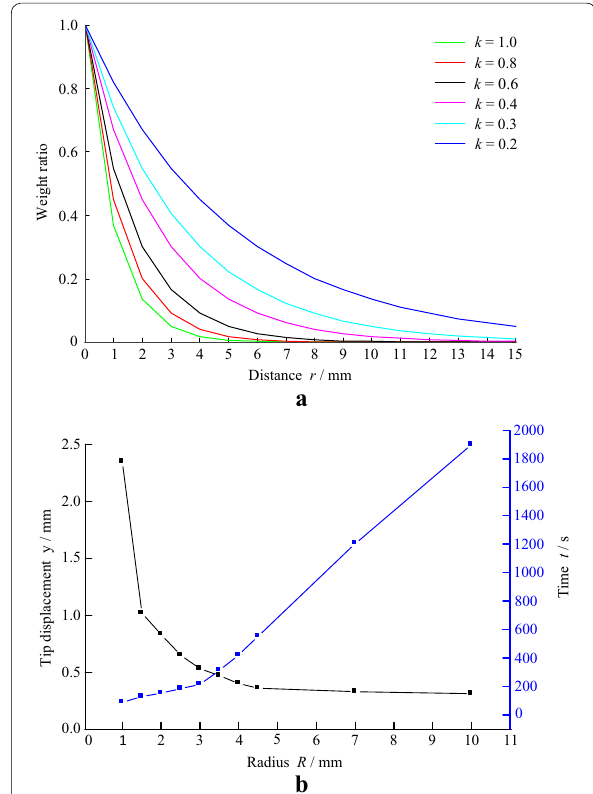
Figure 4 Validation of the hypothesis of LRDM method: a weight function curves; b relationship between tip displacement and solution time for various radii